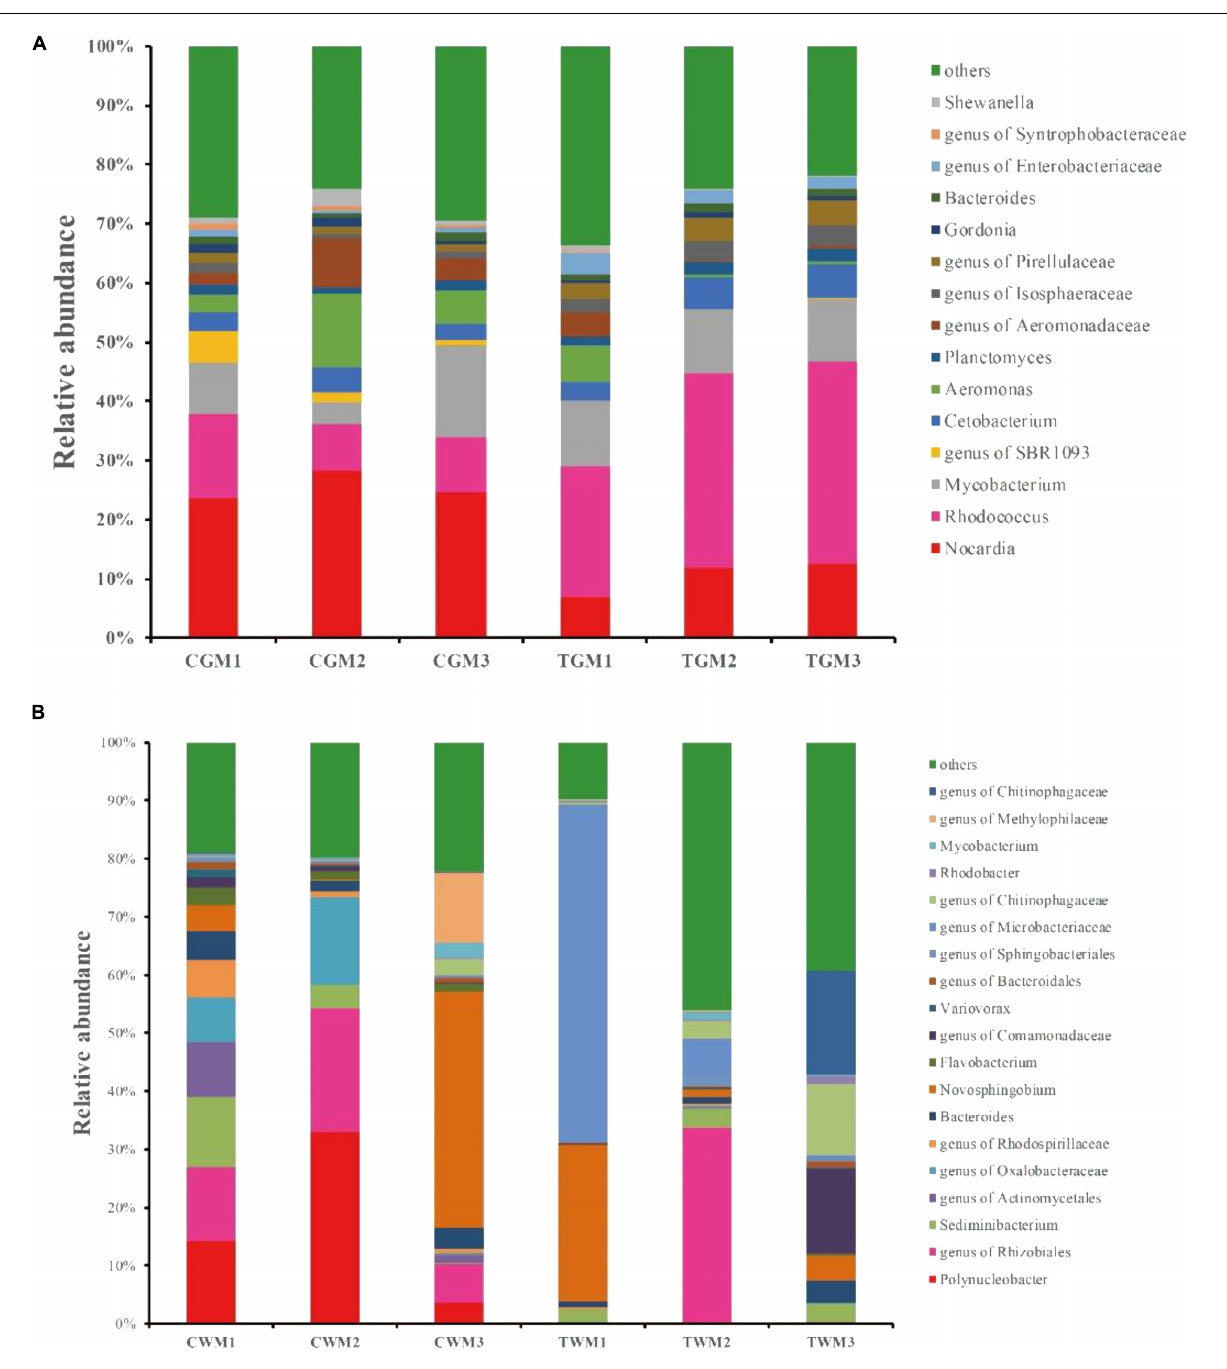
obtained from the 12 samples. The rarefaction curves appear to reach the saturation plateau ( Supplementary Figure 2 ), indicating that the analysis covered most microbial